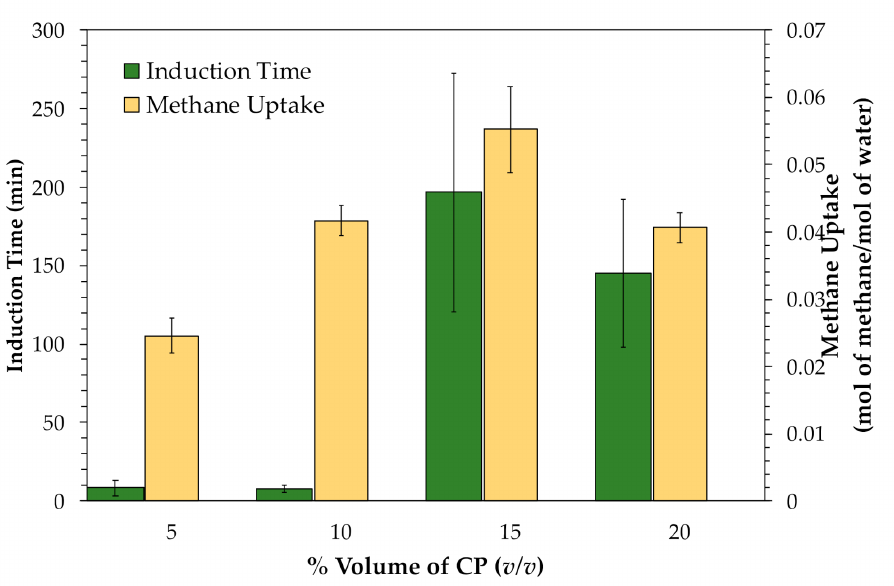
Figure 6. E ff ects of CP concentrations (% v / v ) on the induction time of hydrate formation with CP at 2.5 ◦ C and 8 MPa in the batch